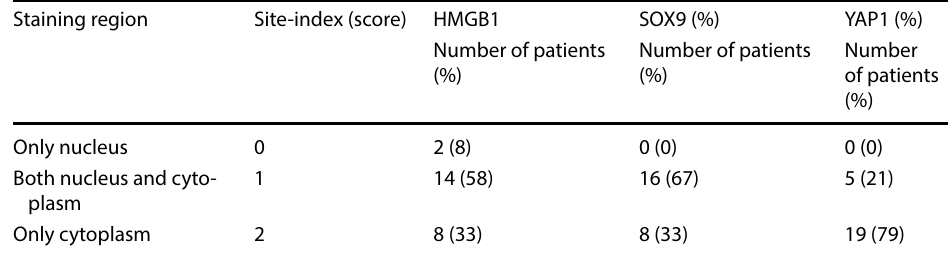
Table 2 Classification of positive staining region in human Clonorchis sinensis - infested cholangiocarcinoma (CS-CCA) tissues as “site-index” score